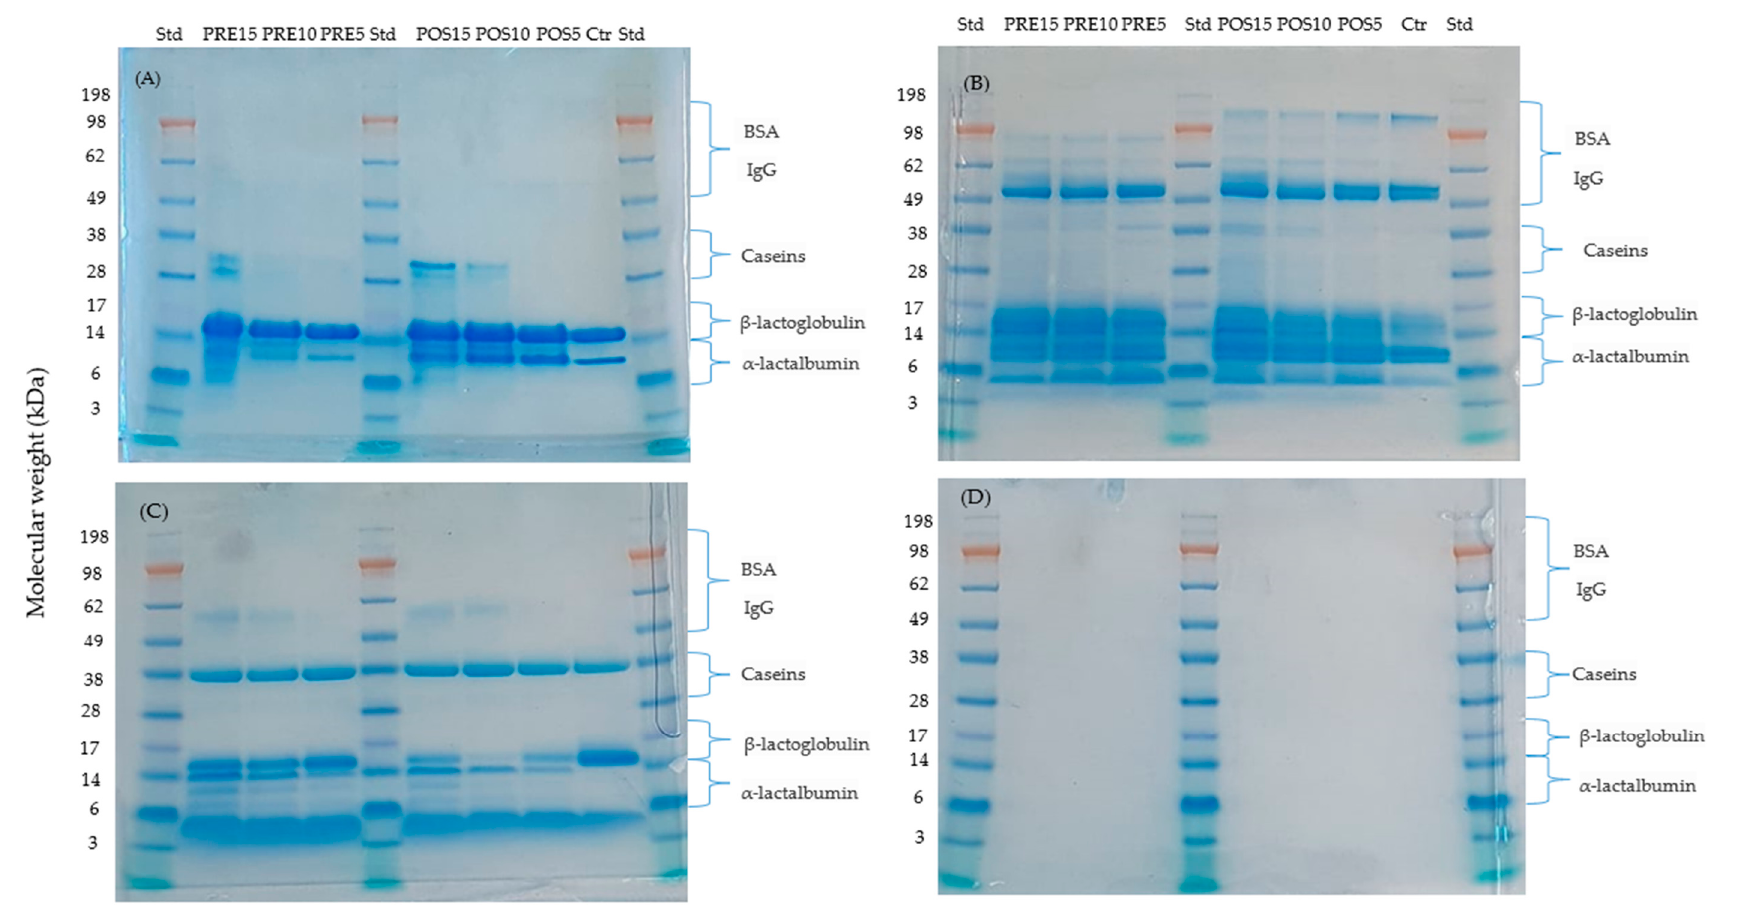
Figure 1. Representative SDS-PAGE images of proteins profile of control and tamarillo yoghurts during the gastrointestinal digestion simulation. ( A ): undigested sample, ( B ): oral phase, ( C ): gastric phase, ( D ): intestinal phase. Numbers on y axis represent molecular weight in kDaltons (kDa). Lanes from left to right: standard, PRE15, PRE10, PRE5, standard, POS15, POS10, POS5, control and standard, respectively. POS5, POS10 and POS15: 5%, 10%, 15% of tamarillo powder was added post fermentation, respectively. PRE5, PRE10 and PRE15: 5%, 10%, 15% of tamarillo powder was added to milk and starter culture prior to fermentation, respectively. Ctr: Control, Std: Standard.